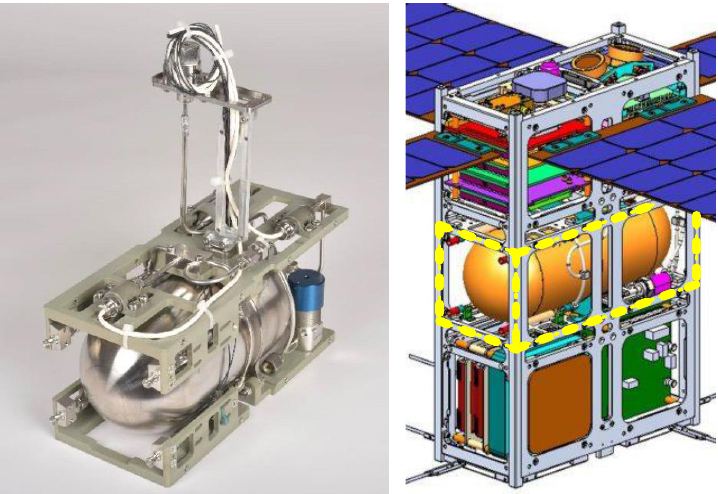
Figure 2. Left: Photograph of the integrated Adelis-SAMSON satellite propulsion system. Right: Illustration of the propulsion system inside the Adelis-SAMSON nano-satellite [11].